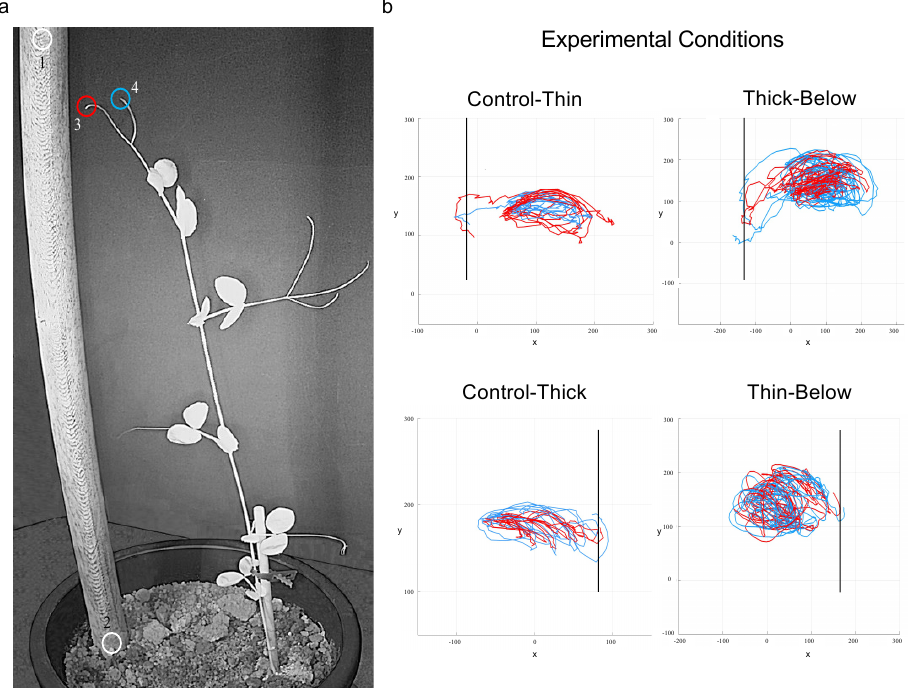
Figure 3. The landmarks considered and examples of the spatial trajectories. ( a ) The landmarks considered were the support (1, 2) and the tip of the tendrils (3, 4). The colors of the circles correspond to the colors of the trajectories shown in the right-side panel (i.e., light-blue, and red lines in panel b refer to the individual trajectory for each tendril). ( b ) represents the trajectories for the tip of the tendrils for the ‘Control-Thin’, ‘Thin-Below’, ‘Control-Thick’ and ‘Thick-Below’ support conditions. The support is a solid vertical line. The axes x and y refer to the sagittal and vertical axis in mm, respectively. Please note that the plant leaned toward the support and the tendrils grasped it for all the